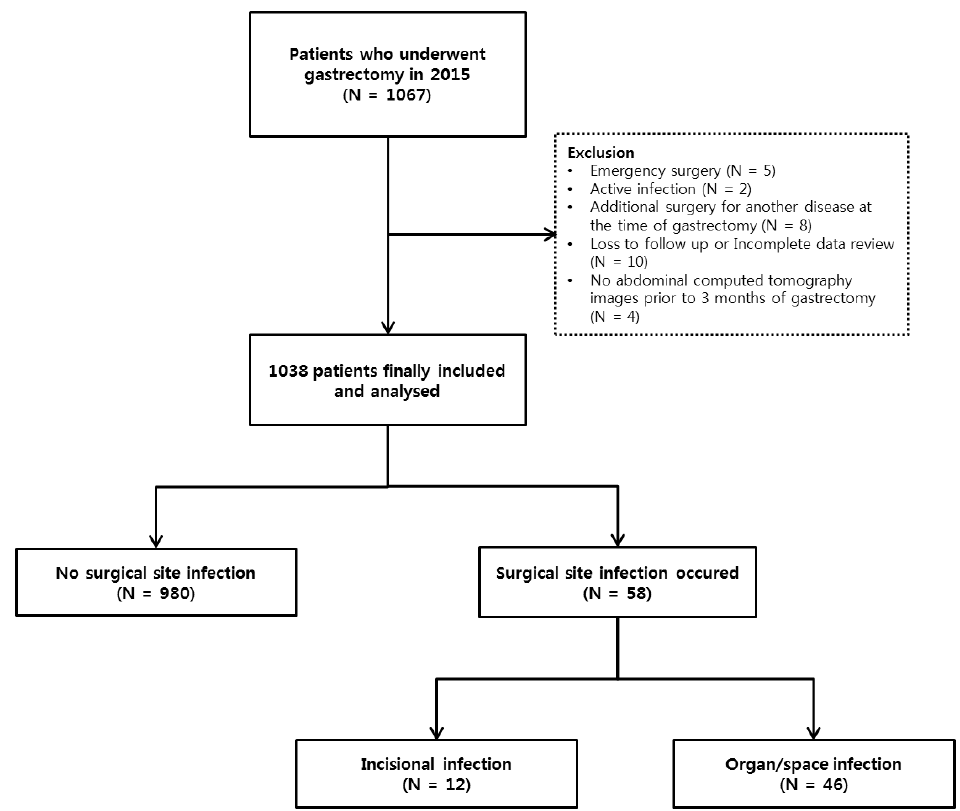
Figure 1. Flow diagram of study process.